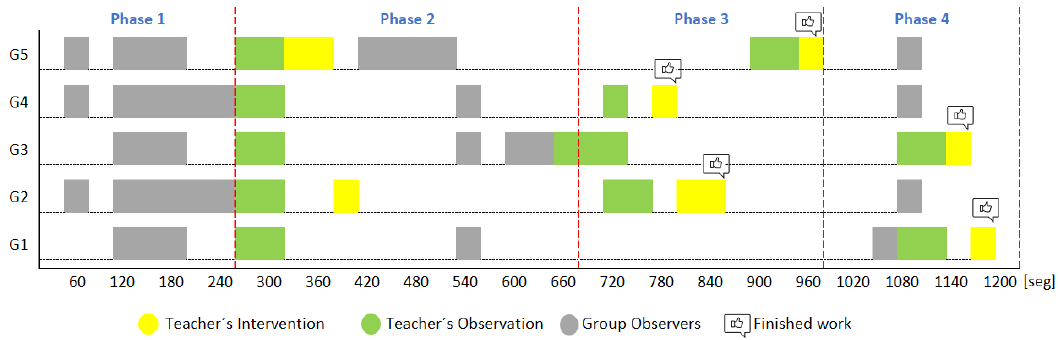
Figure 7. Chronology of events identified during the